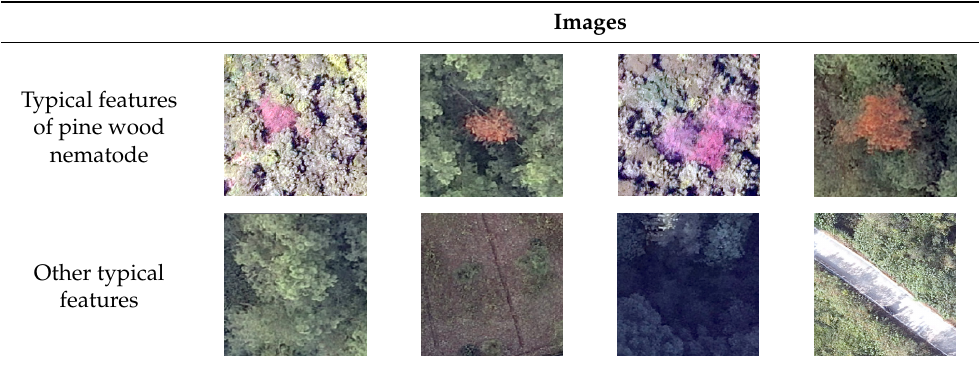
Table 2. Remote sensing images of typical features.